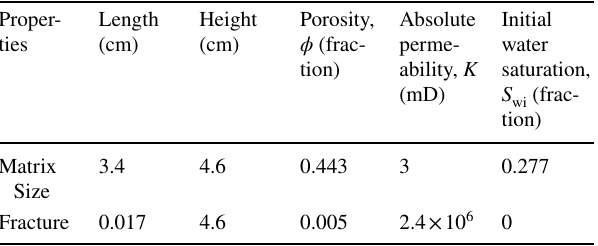
Fig. 10 The relationship between oil recovery and injection volume of surfactant solution